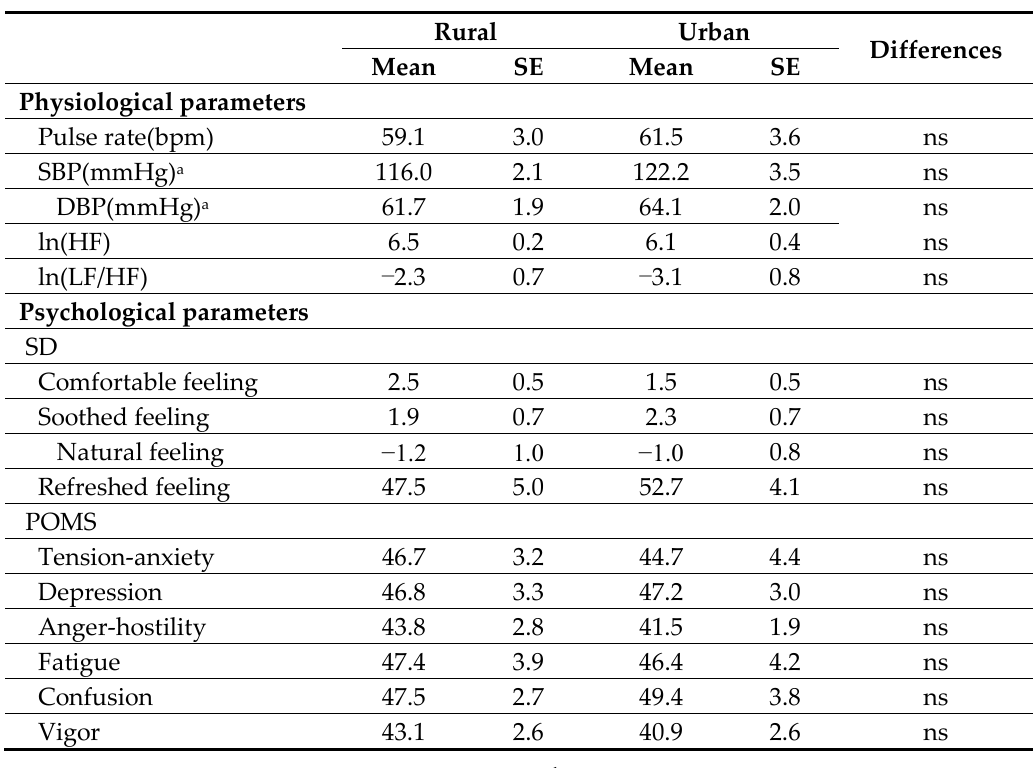
Table 1. Baseline values of the subjects in rural and urban environments.